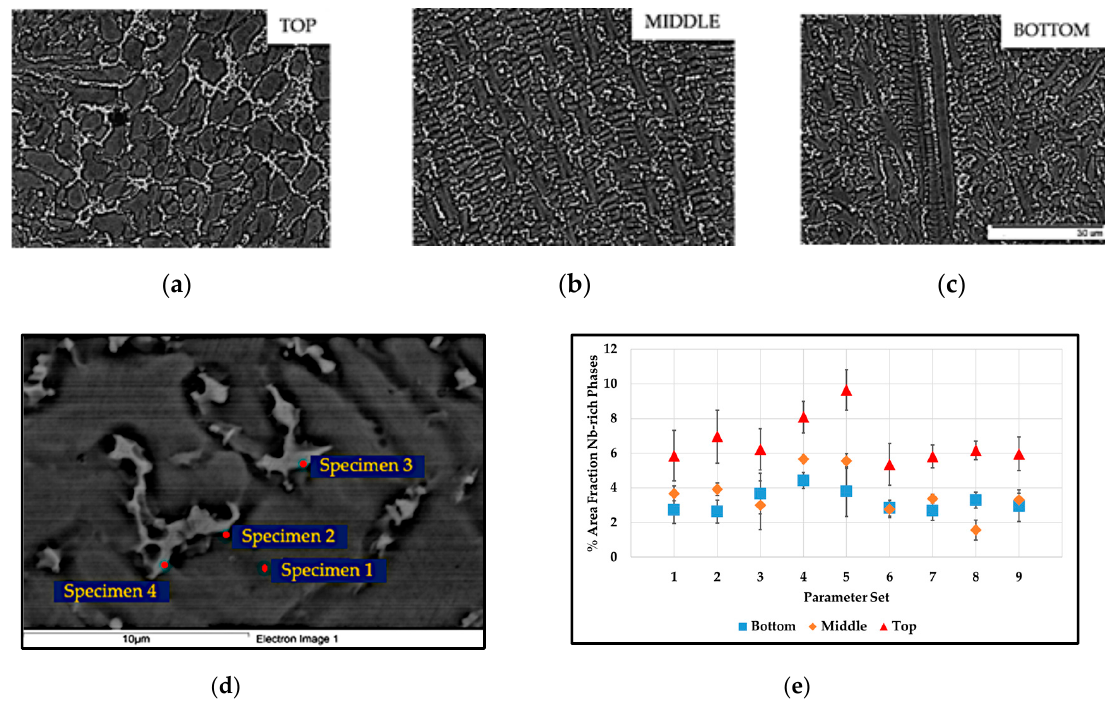
Figure 8. SEM Micrographs depicting variation in Nb-rich phase fraction in ( a ) top; ( b ) middle; ( c ) bottom regions in a deposition pertaining to parameter set 1 (refer to Table 2). ( d ) EDS mapping of Nb-rich precipitates (Spectrum 2–4) and matrix (Spectrum 1); ( e ) plot showing area fraction of Nb-rich eutectic phases for various